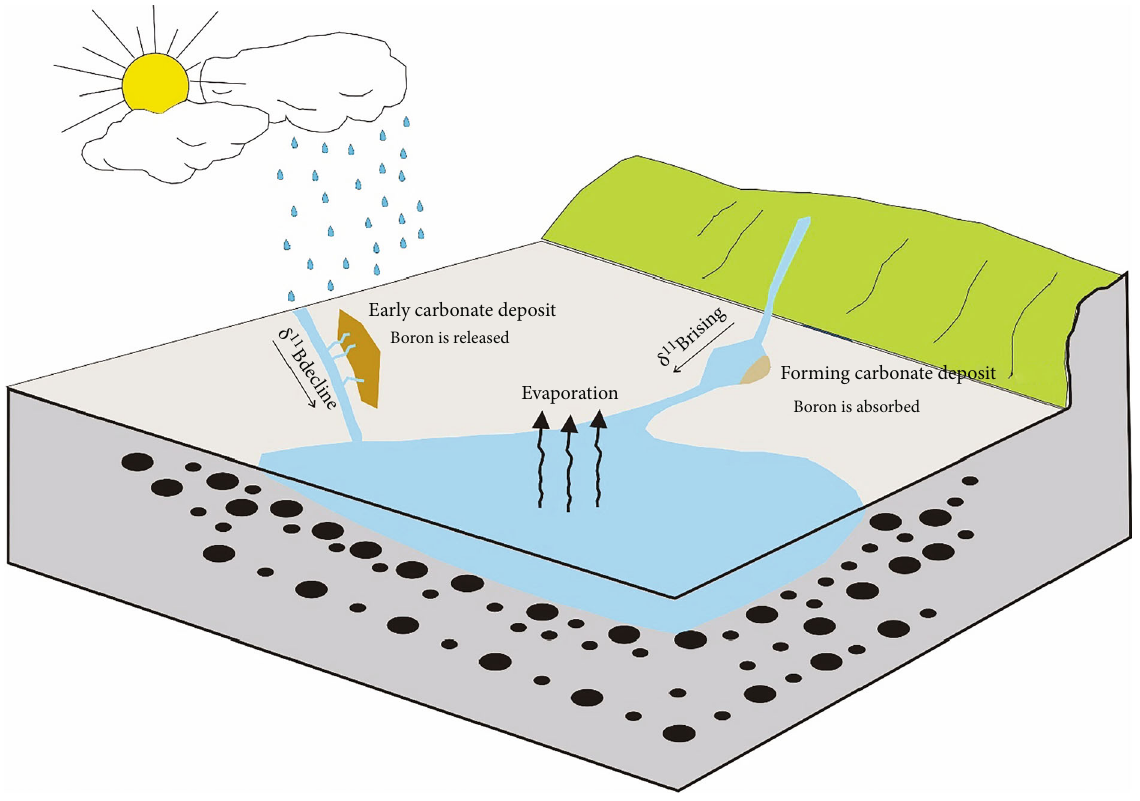
Figure 8: Schematic diagram of the process of boron release from carbonate